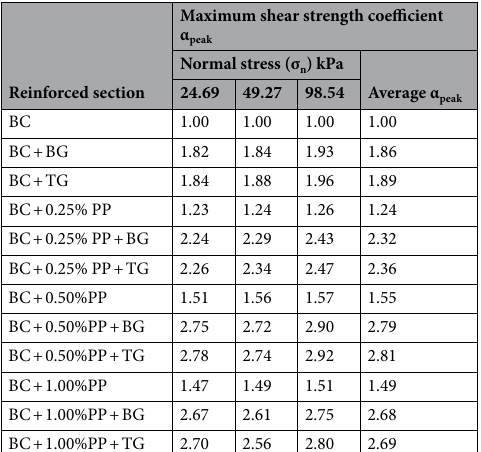
Table 6. maximum shear strength coefficients for normal stresses of 24.69, 49.27 and 98.54